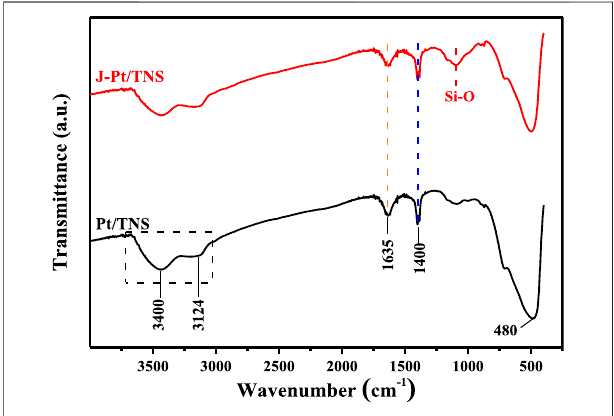
FIGURE 3 | FTIR spectra of the J-Pt/TNS and